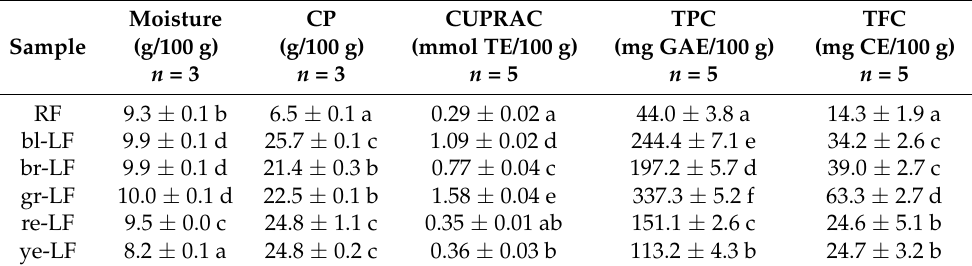
Table 4. Moisture and crude protein (CP) content, cupric ion-reducing antioxidant capacity (CUPRAC), total polyphenol (TPC) and total flavonoid (TFC) content of lentil flours compared to white rice